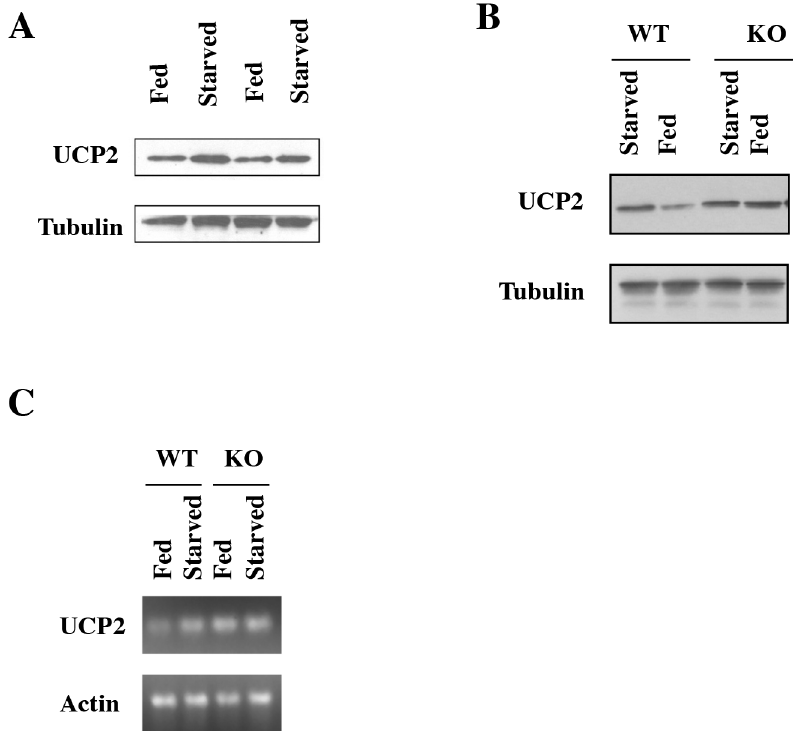
Fig 7. UCP2 mRNA or Protein Levels in Fed or Starved Wild-Type Mice. Western blot for UCP2 in isolated islets in two ad libitum and two starved mice. (B) Western blot for UCP2 in wild-type (WT) or Sirt1 KO littermates either fed ad libitum or starved for 18 h. The experiment shown is representative of four pairs of wild-type and KO littermates analyzed. (C) RT-PCR for UCP2 in wild-type or Sirt1 KO mice fed or